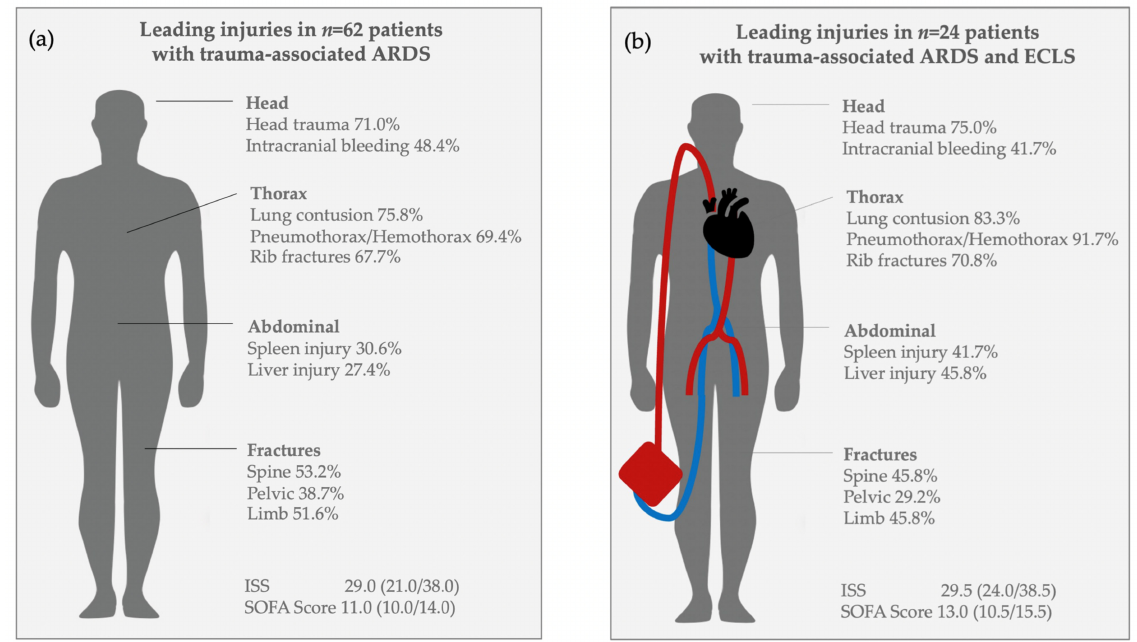
Figure 2. Injury patterns. ( a ) Leading injuries in all patients with trauma-associated ARDS. ( b ) Leading injuries in patients with trauma-associated ARDS and ECLS